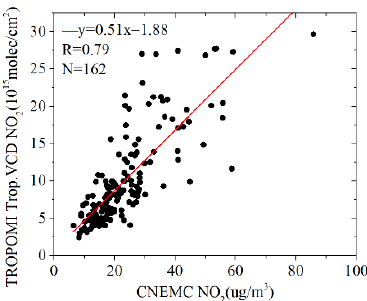
Figure 4. Scatterplot of the monthly averaged NO 2 from CNEMC and TROPOMI NO 2 in the 13 prefecture-level cities in Jiangsu Province.